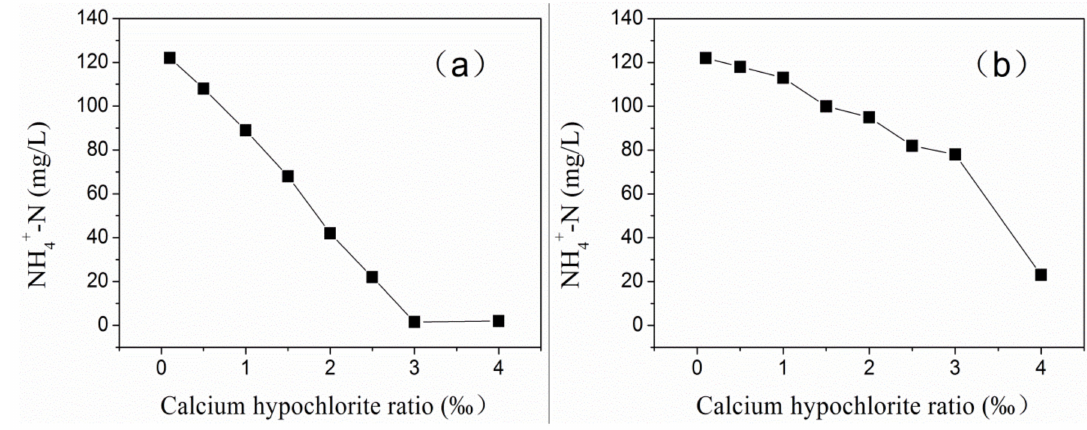
Figure 7. Comparison diagram of the NH 4 + -N removal e ff ect in di ff erent dosing sequences. ( a )